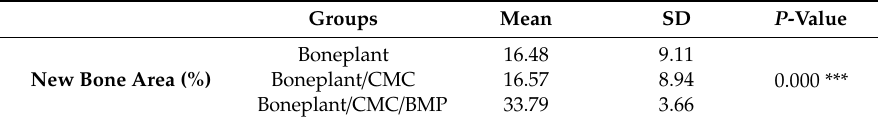
Table 2. New bone area percentages within the region of interest (n = 5 per group).